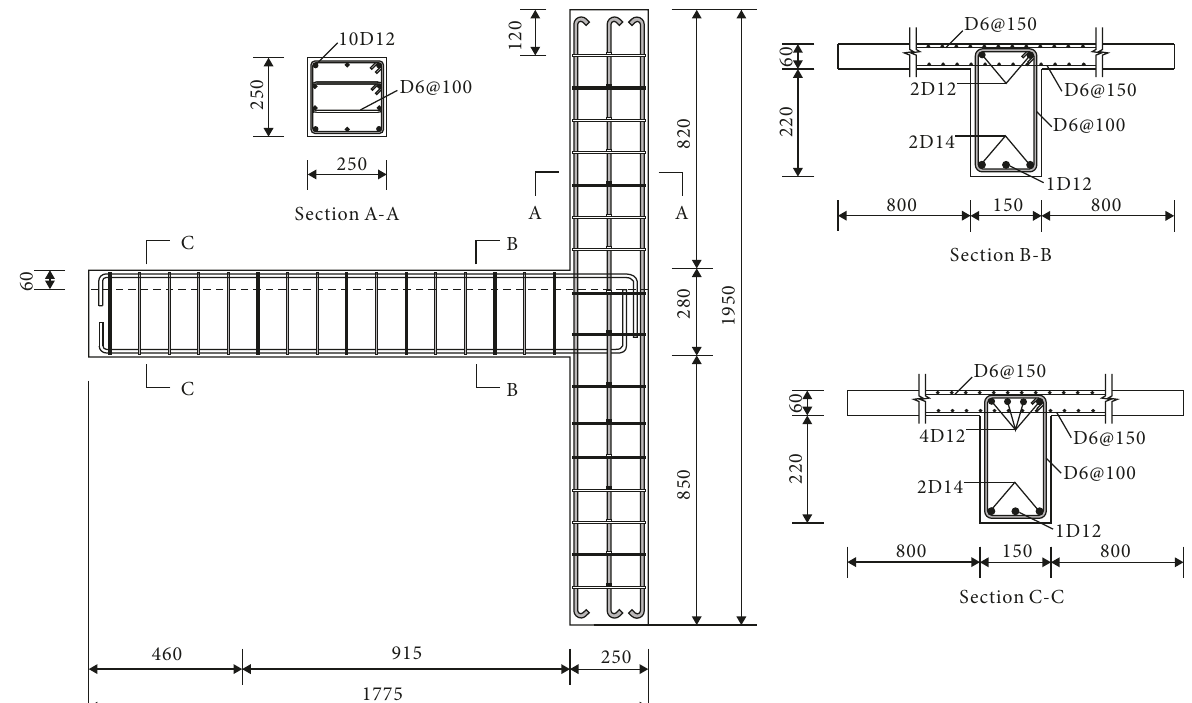
diameter of the deformed bar). (cid:31)